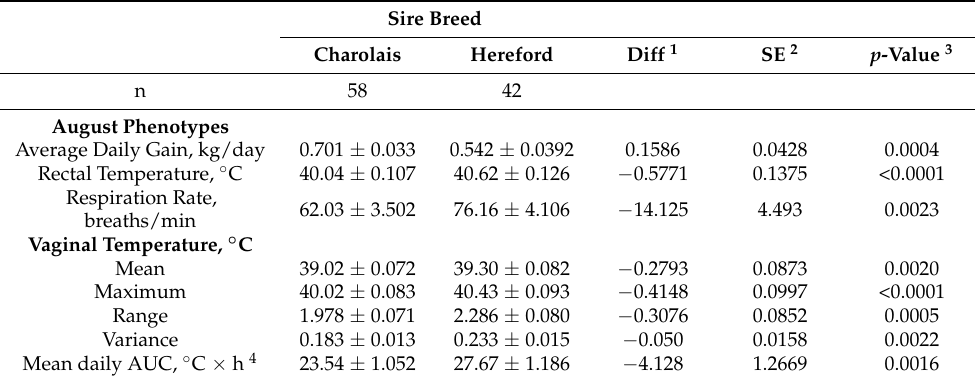
Table 2. Least square means ± standard error for significant phenotypic differences in response to sire breed are presented along with pairwise comparisons between sire breeds for each phenotype. Sire